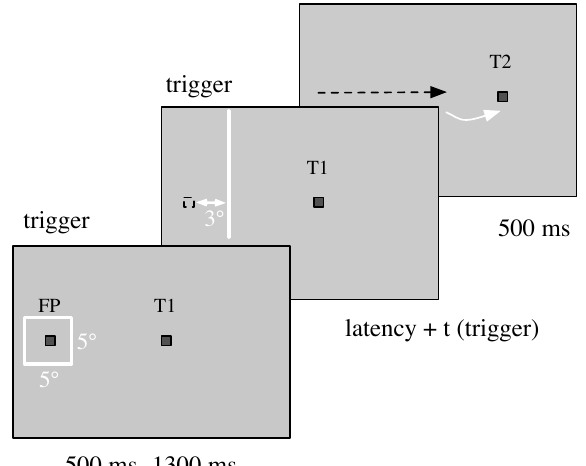
Figure 1 . Adaptation procedure. The subject initially fixated FP, which was visible for 500 ms plus a variable time. Their gaze was triggered to a 5 x 5 deg window centered around FP. When FP was extinguished the subject had to perform a sac- cade to T1. T1 was replaced by T2 as soon as gaze crossed a 3 deg threshold rightwards to FP. T2 was visible for further 500 ms thereafter. In the short saccade experiment the distance from FP to T1 was 14 deg. In the long saccade experiment it was 20 deg. The distance from T1 to T2 was 6 deg in both